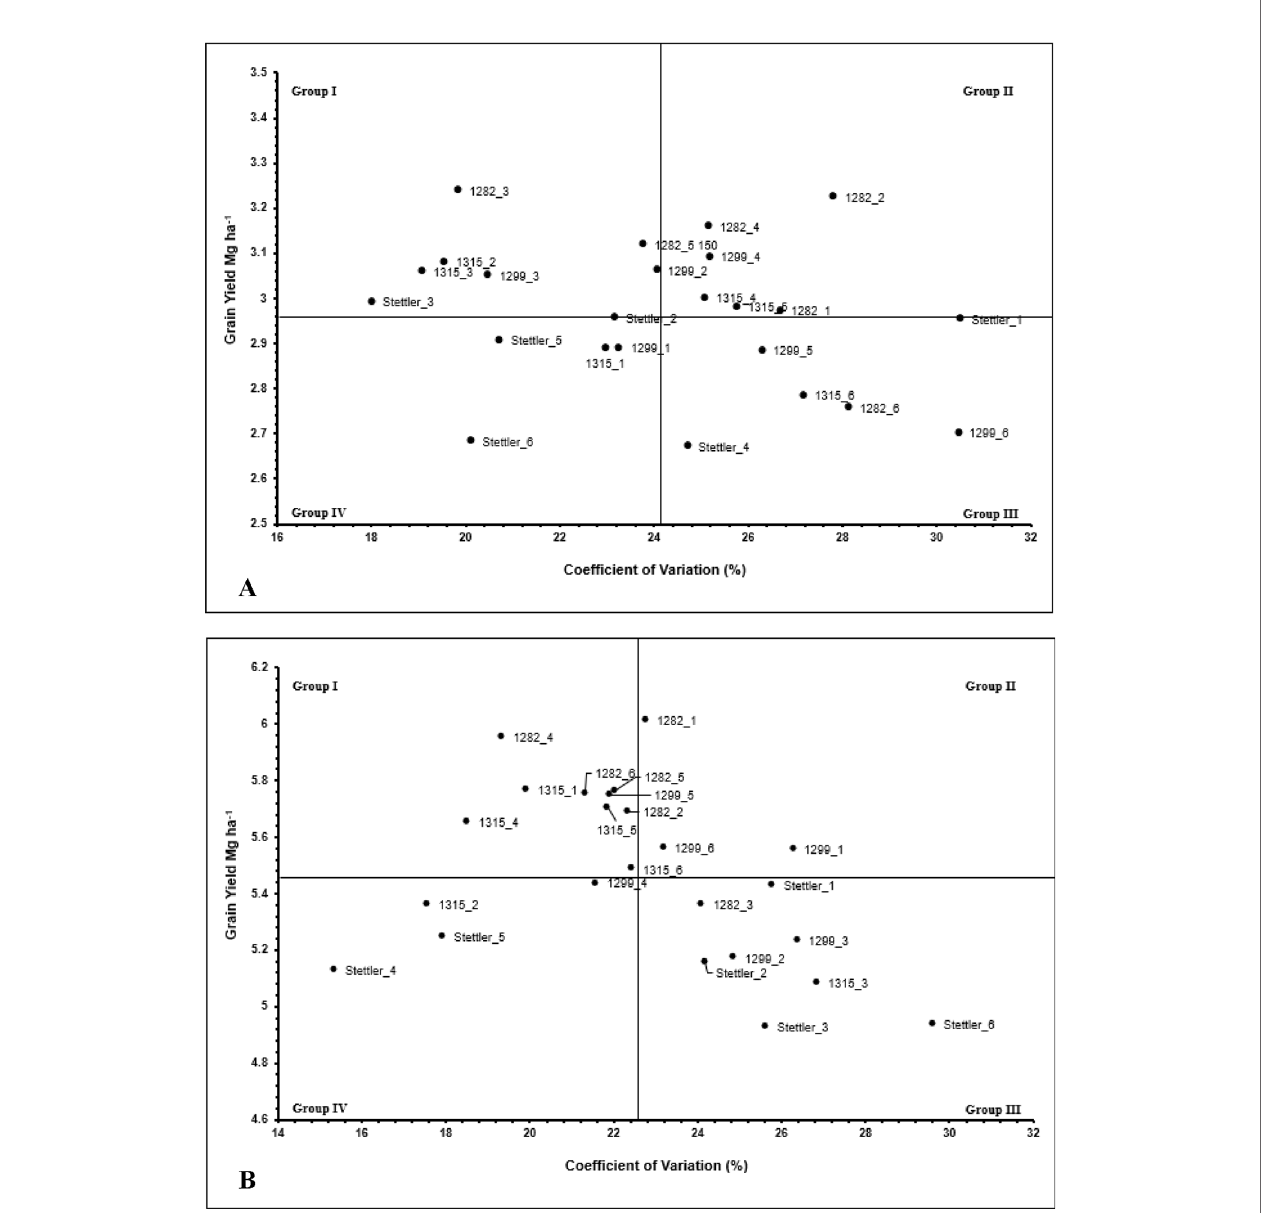
FIGURE 3 | Biplots summarizing yield means vs . coef fi cient of variation (CV) for (A) : sites south of 51°N latitude, (B) sites north of 51°N latitude. Abbreviations are as follows: I) fi rst number/name represents the wheat line (AC Stettler, LQ1282A, LQ1299A, and LQ1315A). II) Second number represents planting date (1 – 6). Grouping categories: group I: high mean, low variability; group II: high mean, high variability; group III: low mean, high variability; group IV: low mean, low